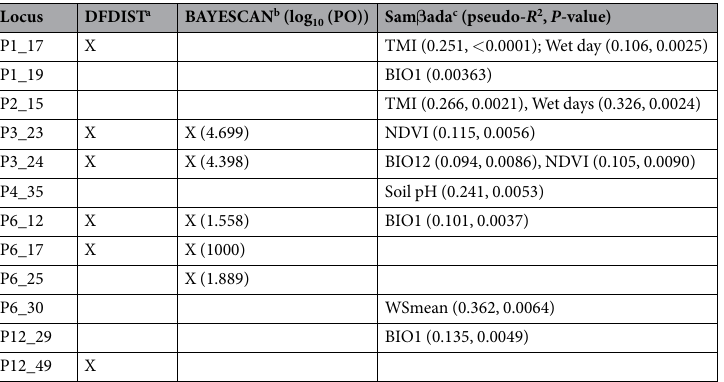
Table 3. Amplified fragment length polymorphic (AFLP) loci identified potentially evolved under selection by DFDIST and BAYESCAN neutrality test methods and association of allelic frequencies with values of environmental variables. a For DFDIST, 95% significance level and 5% false discover rates were used. b For BAYESCAN, a log 10 (probability odds) (log 10 PO) above 1.5 indicated a very strong outlier with a 5% false discovery rate. c For Sam β ada, values of Nagelkerke’s pseudo- R b are indicated (Nagelkerke 1991). Statistically significant at P < 0.01, corresponding to a confidence threshold after Bonferroni corrections of 2.741 x − 6. BIO1, annual mean temperature; BIO12, annual precipitation; NDVI, normalized difference vegetation index; Wet days, number of days with > 0.1 mm of rain per month; WS mean , mean wind speed; TMI, soil moisture